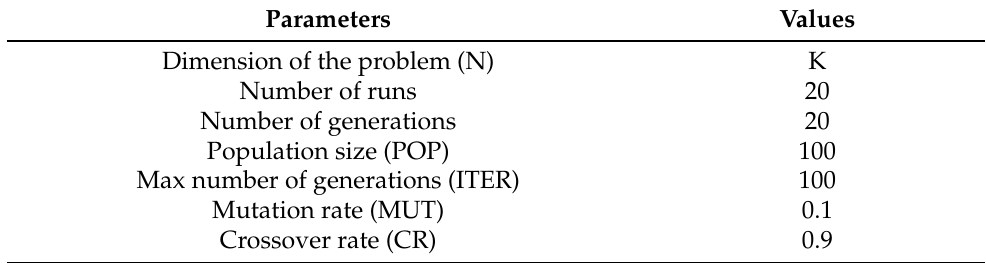
Table 3. Parameters of the genetic algorithm.